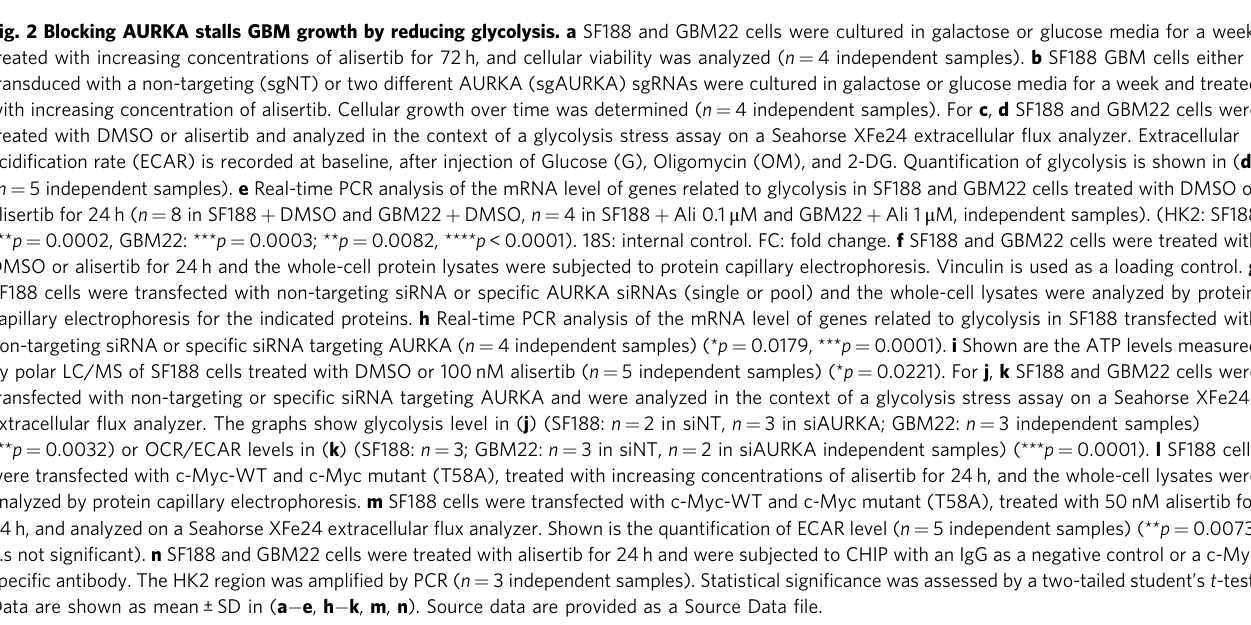
(Fig. S6b). Following treatment with alisertib or speci fi c silencing of Aurora kinase A we detected a signi fi cant suppression of both mRNA and protein levels of GLUT1, HK2, and LDHA in SF188 and GBM22 cells (Fig. 2e – h). We also con fi rmed the down- regulation of these transcripts in an orthotopic GBM PDX model that we used earlier for the con fi rmation of the suppression of c-Myc protein levels (Figs. S1h, l and S6c). While glycolysis was